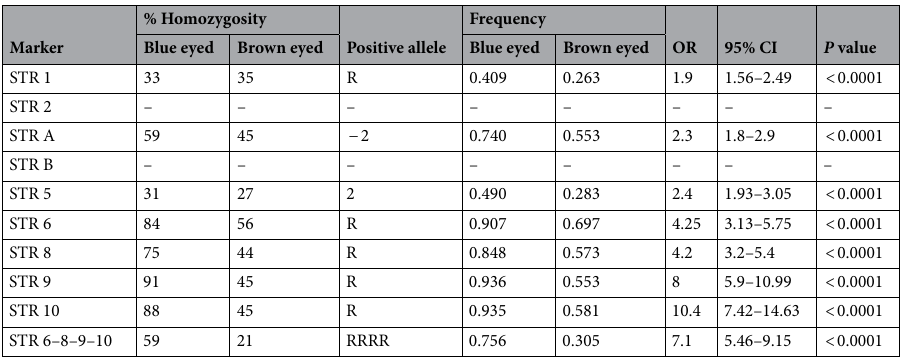
Table 3. Homozygosity and allelic associations in predicted blue and brown eye color Europeans. Predicted blue eyed individuals n = 361 ; predicted brown eyed individuals n = 312. Odds ratios (OR) 95%, confidence interval (CI) and P values were calculated using the software MedCalc.